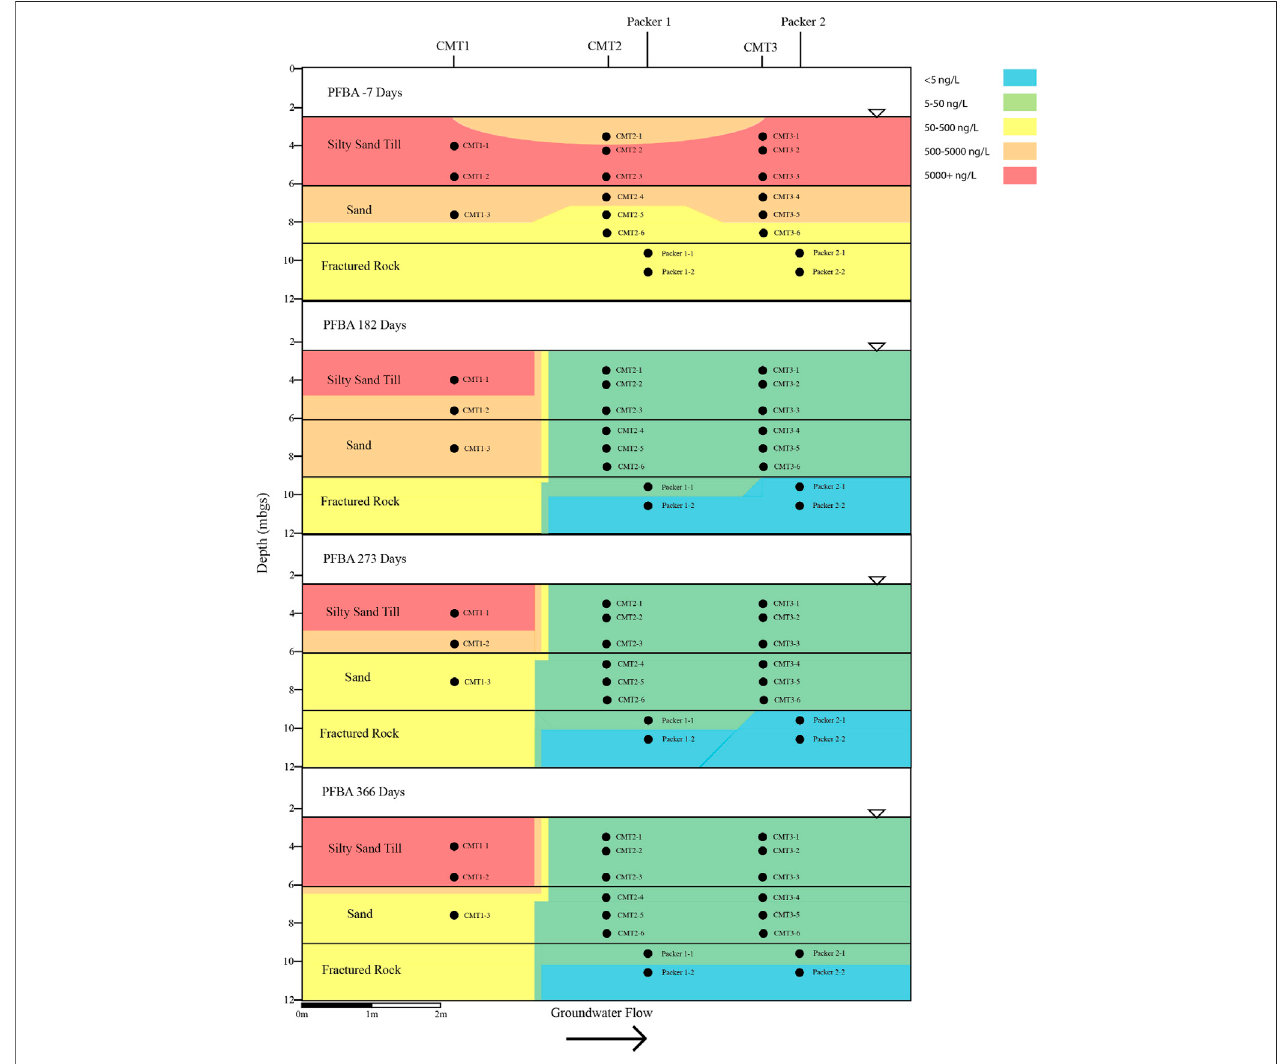
FIGURE 5 | Cross sectional view of PFBA within groundwater determined pre- and post-injection of the CAC within the three aquifers.